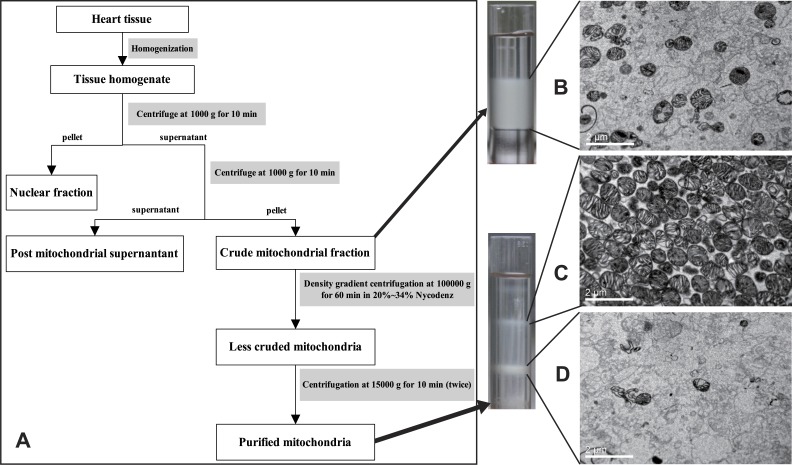
Flow chart of mitochondria preparation.Pure mitochondria are collected with Nycodenz density gradient centrifugation (A) and representative transmission electron micrograph of the isolated purified mitochondria (C). (B) Crude mitochondria. (C) Sample came from 23% to 25% layer of Nycodenz. (D) Sample isolated from the 25% to 30% layer Nycodenz. Scale bars represent 2 µm.